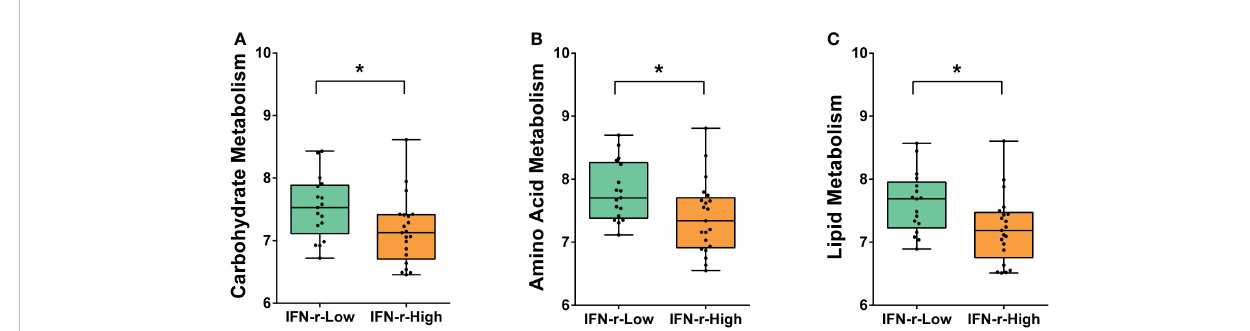
FIGURE 4 Differences of enriched KEGG orthologues markers between the IFN- g -Low and IFN- g -High groups. The values of the points represent the relative abundances of the KEGG orthologues markers related to (A) carbohydrate metabolism, (B) amino acid metabolism and (C) lipid metabolism. The horizontal line and the box indicate the median and the interquartile range (IQR), and the whisker spans the minimum to maximum. * p